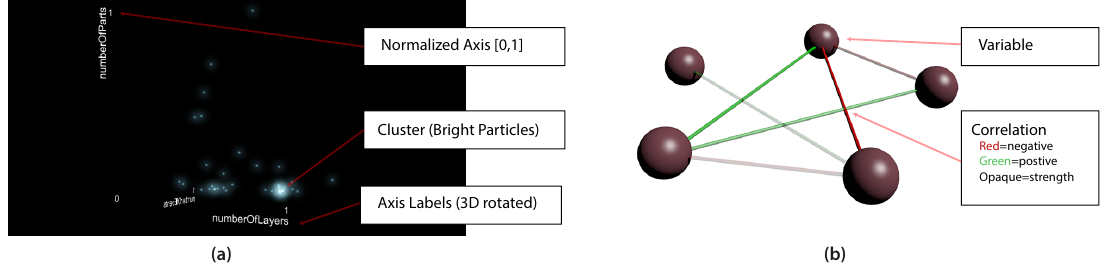
Figure 7. ( a ) Particle-based visualization of additive manufacturing data, where one data point is a print job represented by the variables numberOfLayers, numberOfParts, and numberOfErrors, and ( b ) sample correlation graph to help the user in selecting variables for the